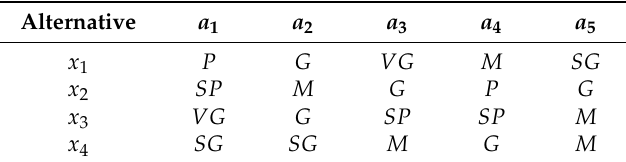
(cid:16) (cid:17) s r given by e 1 . ij 1 4 × 5